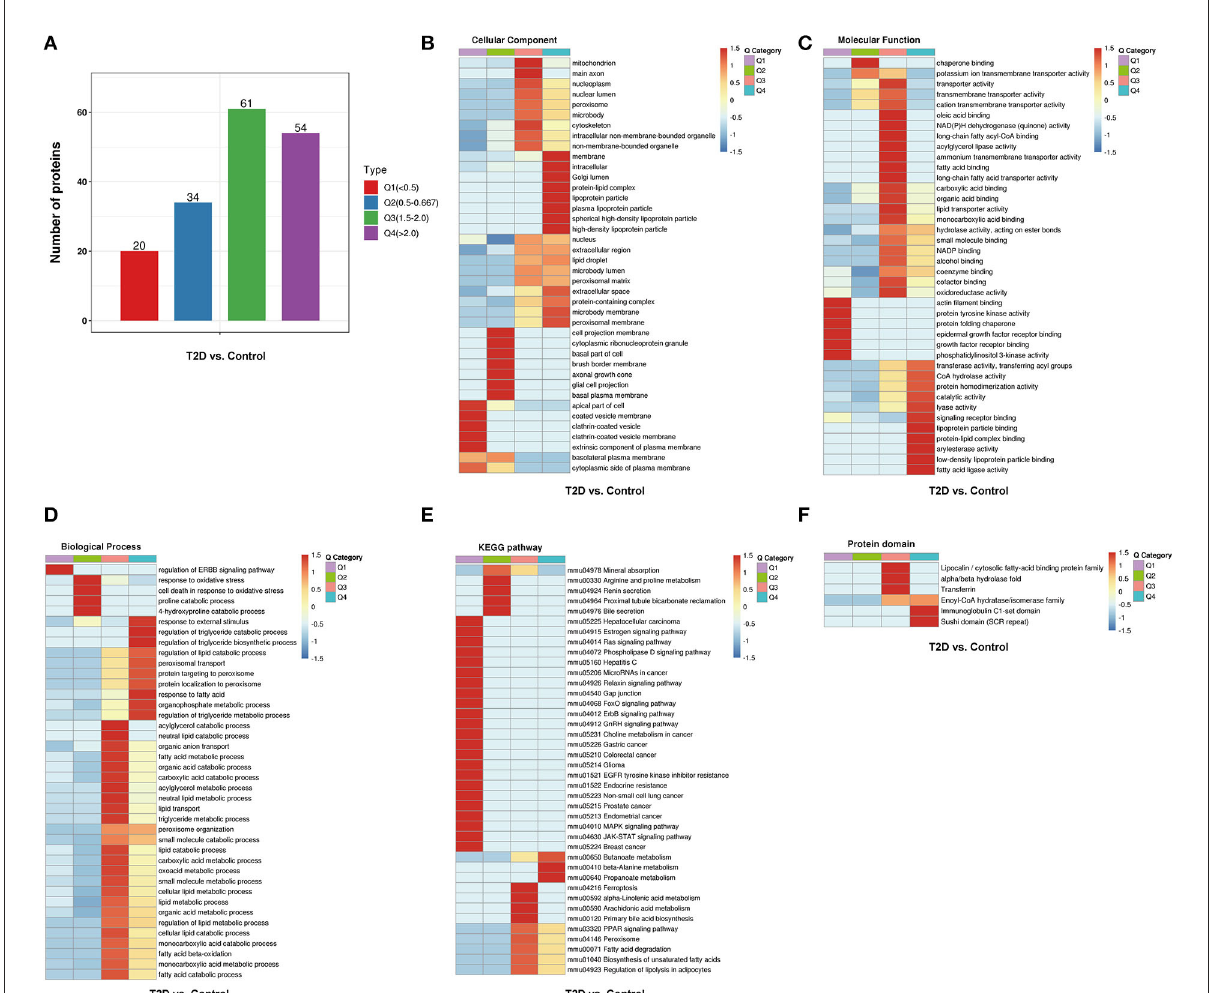
FIGURE5 Hierarchical cluster analysis of DEPs from the WT and db/db mouse heart tissue. (A) According to the degree of fold change (FC), the DEPs were categorized into four groups from Q1 to Q4 (Q means the ratio of db/db mouse group to C57BL/6 mouse group, Q1 < 0.5, Q2 = 0.5–0.667, Q3 = 1.5–2, and Q4 > 2), (B) cellular component, (C) molecular function, (D) biological process, (E) the Kyoto Encyclopedia of Genes and Genomes pathways, and (F) protein domain. The red color indicates stronger enrichment. The blue color indicates weaker